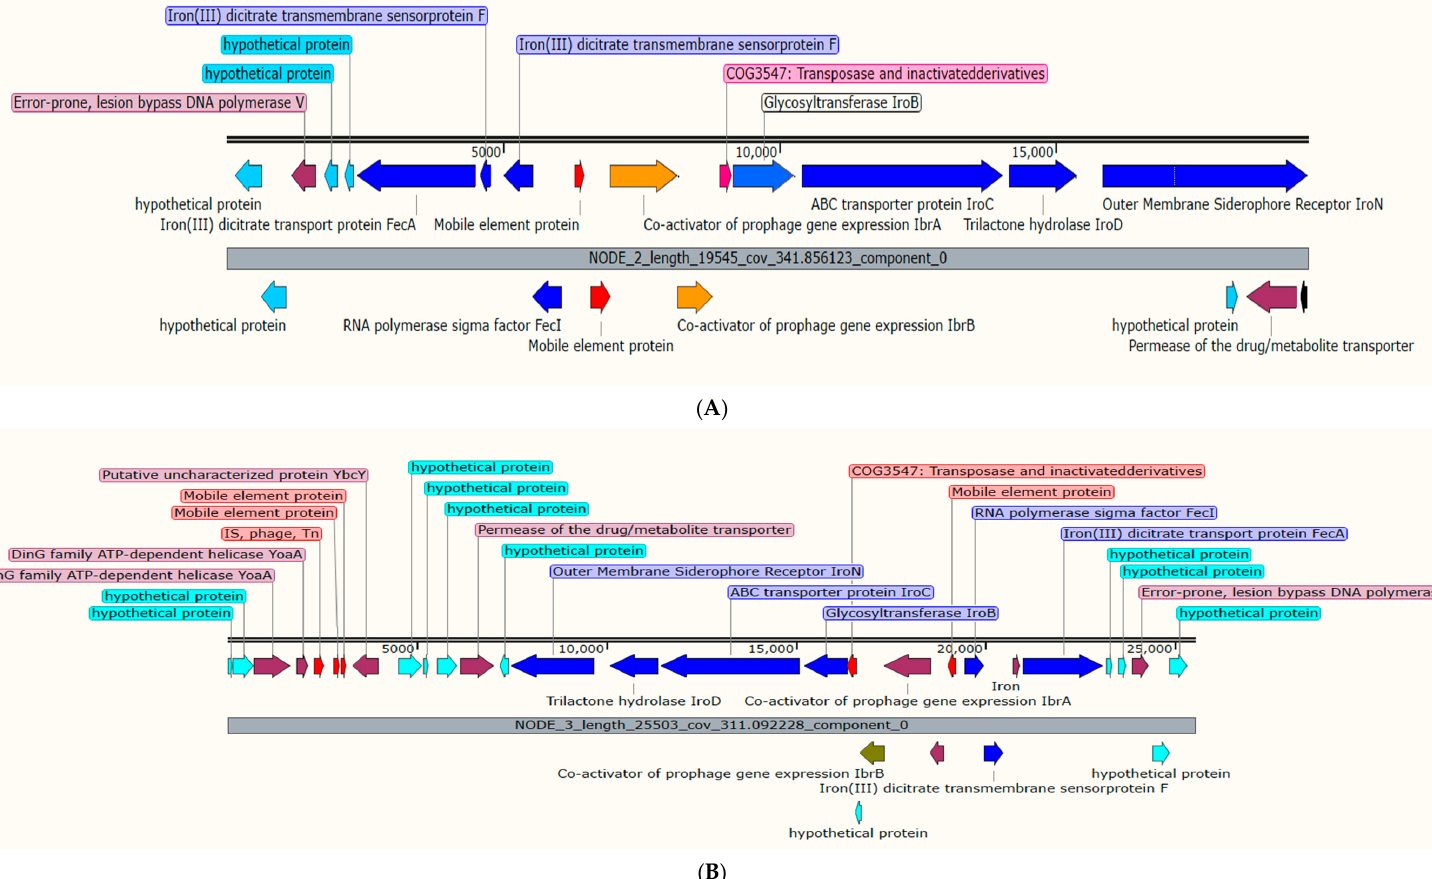
Figure 4. A cluster of enterobactin siderophore receptor genes ( iroB , iroC , iroD , and iroN ) (in blue colors) in the plasmid p F1K6P0037-1 of both isolates K6 ( A ) and K7 ( B ). The associated mobile genetic elements are shown in red colors.